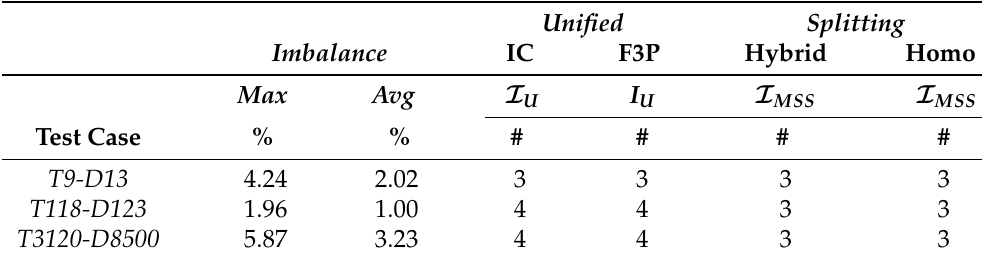
Table 6. The amount of maximum and average voltage unbalance of the distribution feeder for the three different test cases and the number of iterations of the three different methods.